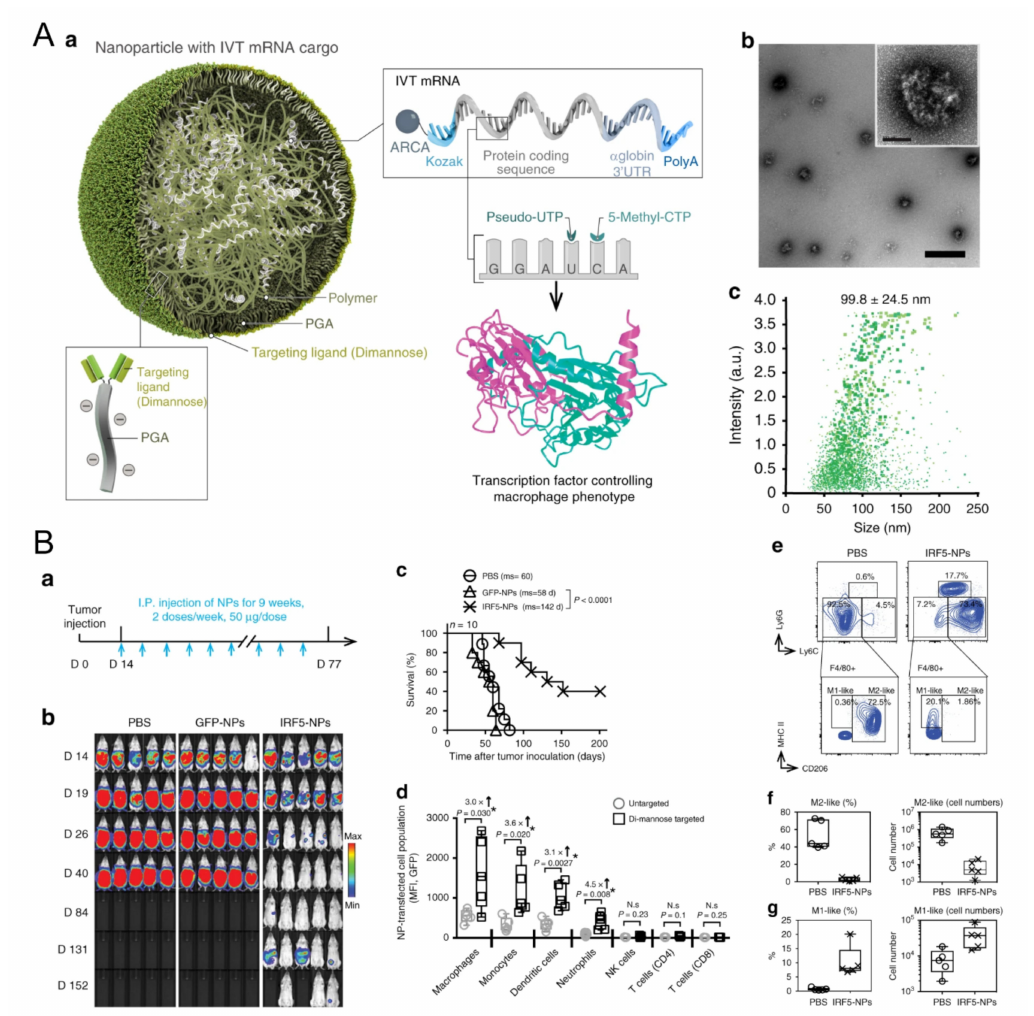
Figure 1. Polymeric nanoparticles loaded with mRNA for macrophage repolarization. ( A ) Characteristics of the polymeric nanocarriers: ( a ) The components of the polymeric nanoparticles (termed IRF5-NPs). ( b ) Transmission electron microscopy of the nanoparticles. ( c ) Size distribution of the nanocarriers. Reproduced with permission [56]. Copyright 2019 Nature Publishing Group. ( B ) IRF5-NPs prolong the survival time of mice with ovarian cancer and reprogram macrophages in vivo. ( a ) Treatment schedule. ( b ) Tumor growth after intraperitoneal administration of IRF5-NPs. ( c ) The survival curves of tumor-bearing mice. ( d ) Quantitation of transfection rates in various immune cells using flow cytometry. ( e – g ) The reprogramming effect of IRF5-NPs on peritoneal macrophages in tumor-bearing mice. Reproduced with permission [56]. Copyright 2019 Nature Publishing